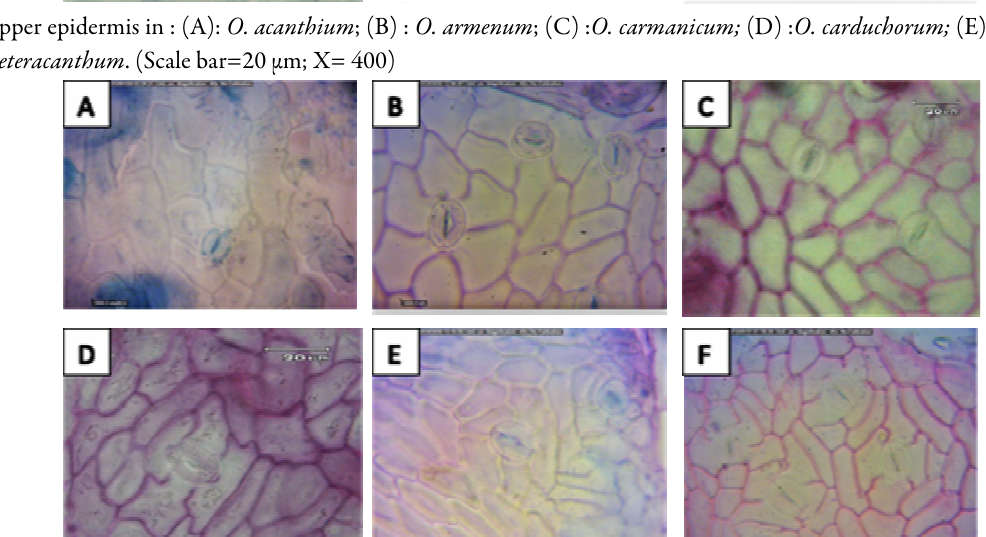
Fig. 6. Lowerl epidermis in: (A): O. acanthium ; (B) : O.armenum ; (C) : O. carmanicum ; (D) : O. carduchorum ; (E) : O. leptolepis ; ( F) :O. heteracanthum. (Scale bar=20 µm; X= 400) Tab. 5. Anatomical quantitative characters of stem in studied species (The unit is micrometer). Cu. T: Cuticle Thickness, Epi. T: Epidermis Thickness, Epi. Le: Epidermis Cell Length, Col. T: Collenchymas Thickness, P. C. T: Parenchyma Thickness, Ecl. Sh. T: Sclerenchymatous Sheaths Thickness, F. Lb. T: Phloem Fiber Thickness, Xyl. F. T: Xylem Fiber Thickness, Phl. T: Phloem Thickness, Xyl. T: Xylem